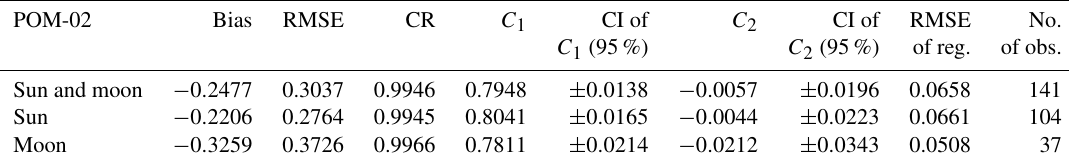
Table 4. Results of the comparison between NIES/HSRL and POM-02 aerosol optical depth. POM-02 Bias RMSE CR C 1 CI of C 2 CI of RMSE No. C 1 (95%) C 2 (95%) of reg. of obs. Sun and moon 0.0437 0.0839 0.8266 0.9611 ± 0 . 0295 0.0486 ± 0 . 0049 0.0715 Sun 0.0432 0.0866 0.7650 0.8877 ± 0 . 0425 0.0573 ± 0 . 0068 0.0743 1192 Moon 0.0466 0.0838 0.8825 1.0477 ± 0 . 0414 0.0405 ± 0 . 0074 0.0694 702